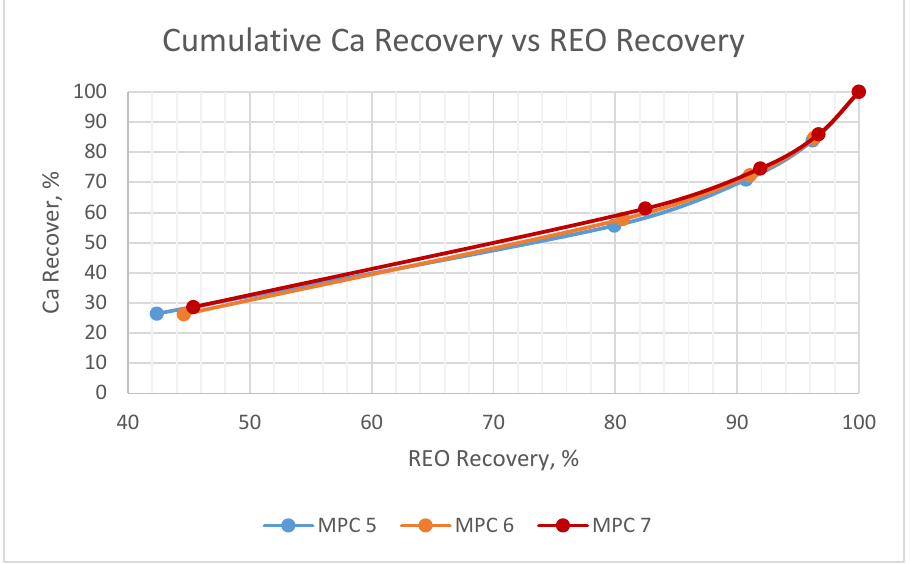
Figure 10. Cumulative Ca recovery vs REO recovery for MPC UF Falcon recovery maximization test- ing.